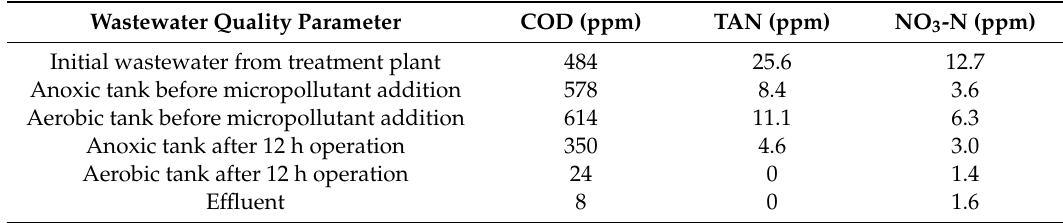
Table 3. Wastewater quality parameters for the initial wastewater received from the treatment plant, the anoxic and aerobic tanks before addition of the micropollutants and at the beginning and end of 12-h MBR (membrane bioreactor) run, and the e ffl